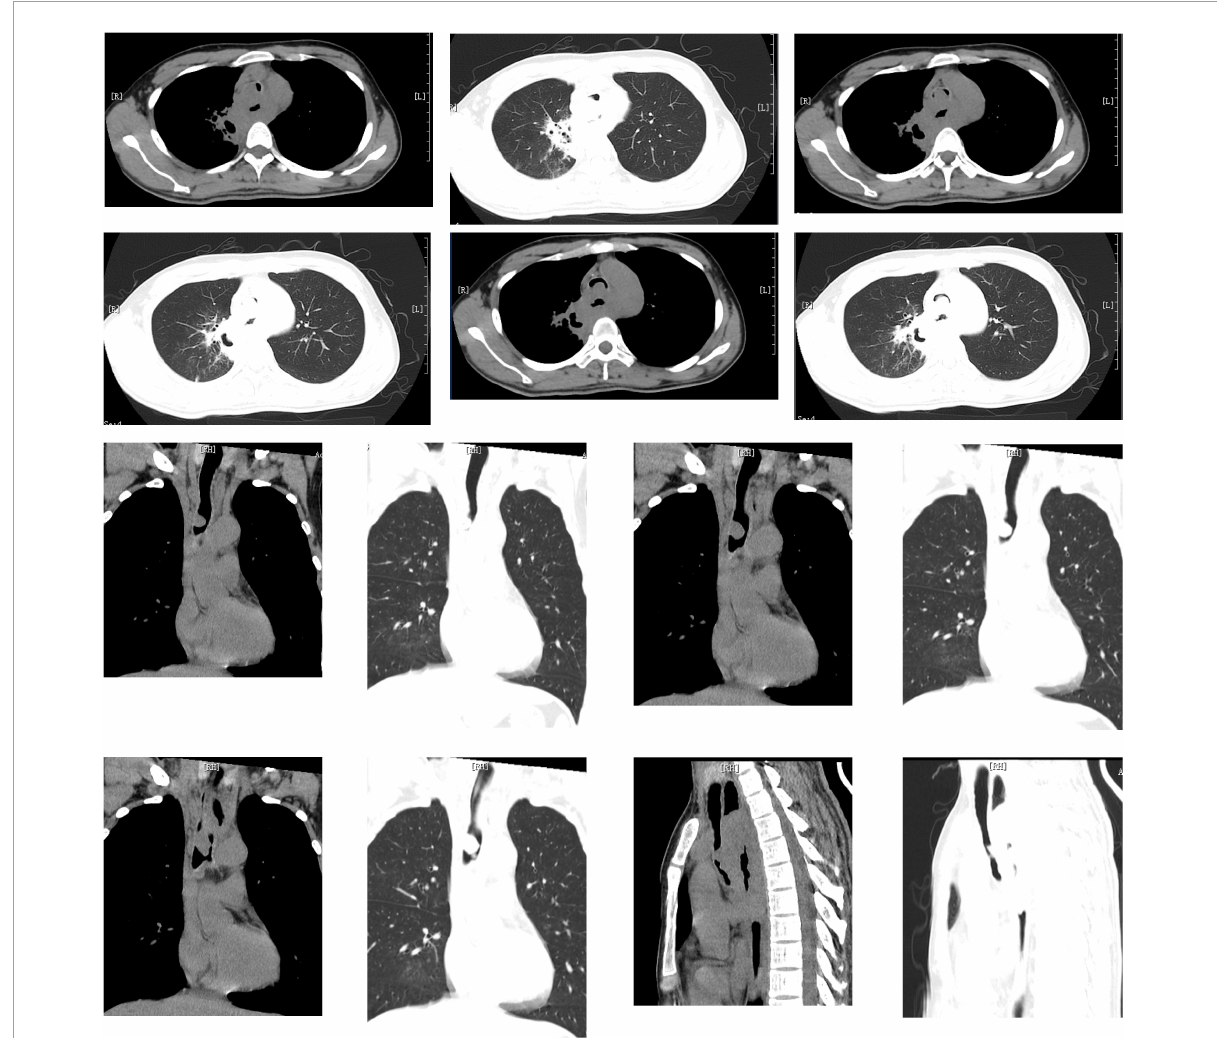
FIGURE1 Cavitary lesions in the right upper lung, new organisms in the main trachea near to the carina which almost completely blocked the lumen (the narrowest part is about 2 mm), mediastinal lymph nodes swelling, obvious thickening of the wall of the middle esophagus and obvious expansion of the upper